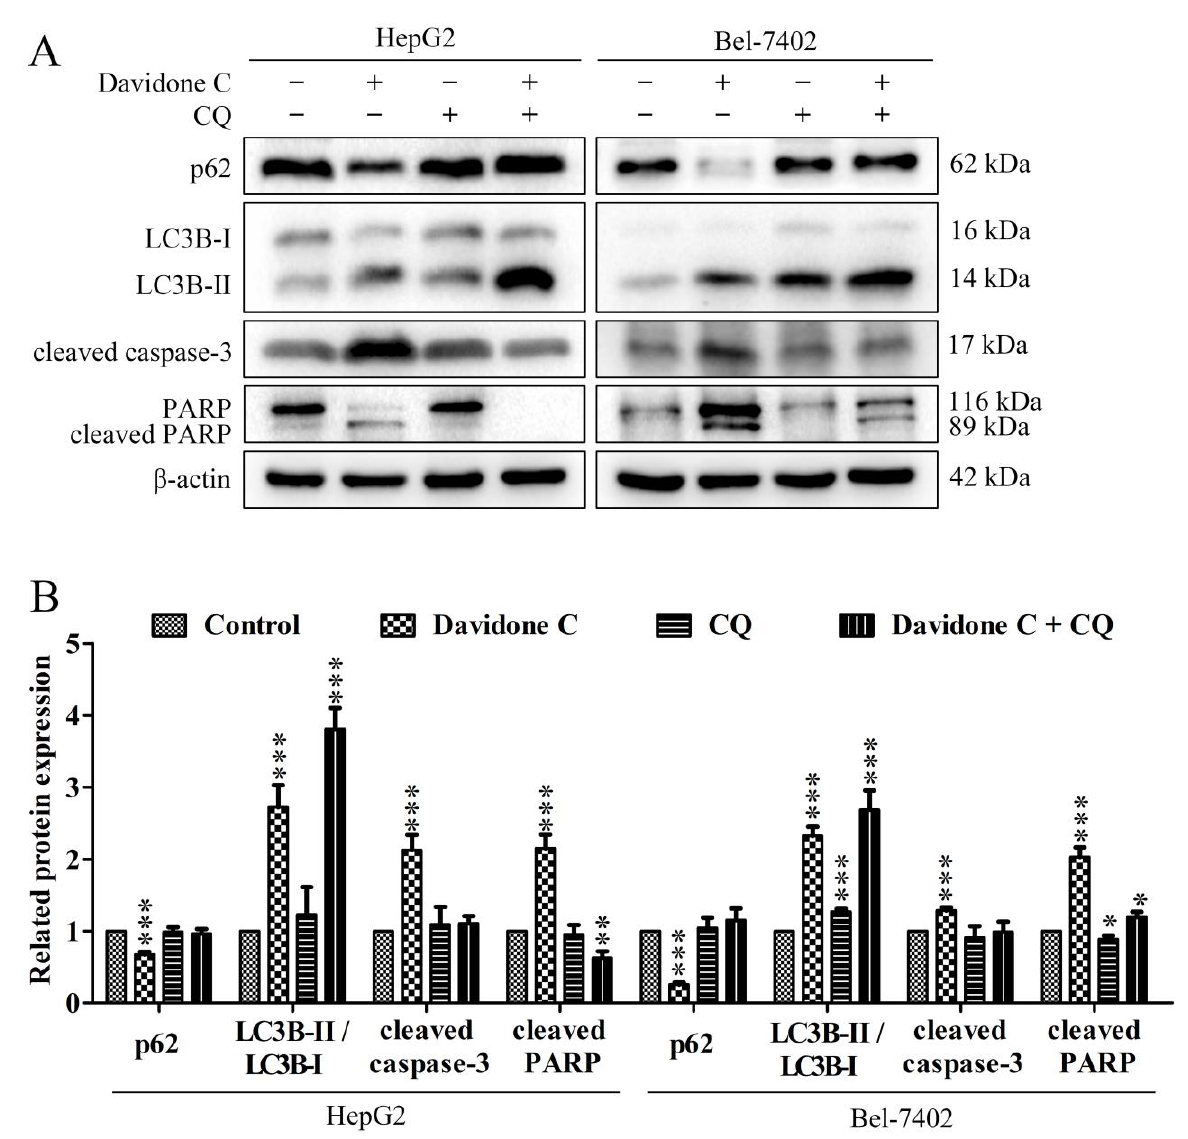
Figure 7. Effects of davidone C with chloroquine on the related proteins of autophagy and apoptosis pathways in HepG2 and Bel-7402 cancer cells. ( A , B ) The related expressions of p62, LC3-II, cleaved caspase-3 and cleaved PARP in HepG2 and Bel-7402 cells were detected by Western blotting. β -actin was used as a control (* p < 0.05, ** p < 0.01 or *** p <